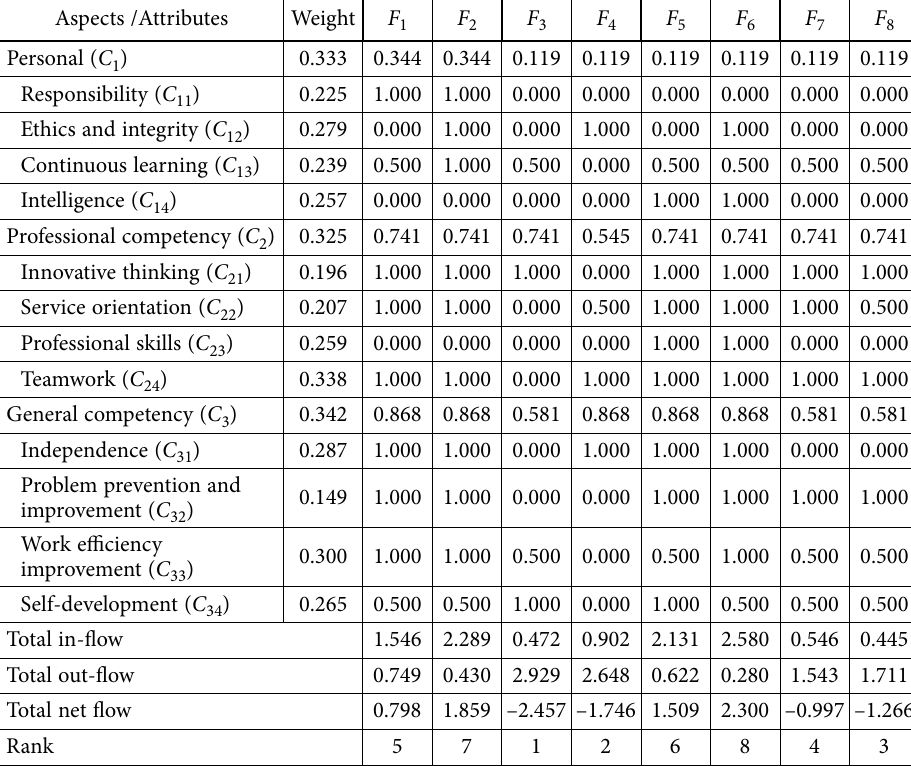
Table 12. Relative gaps and ranking for the eight personnel with the original PROMETHEE method Aspects